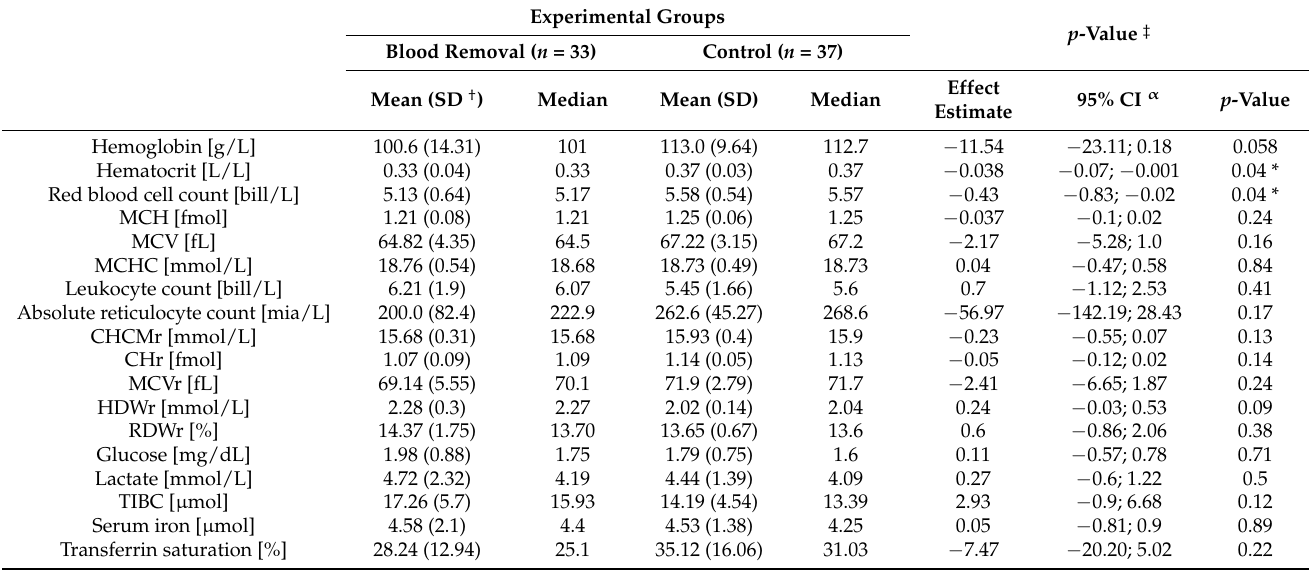
Table 5. Hematologic parameters of newborn piglets (Trial I). Experimental Groups